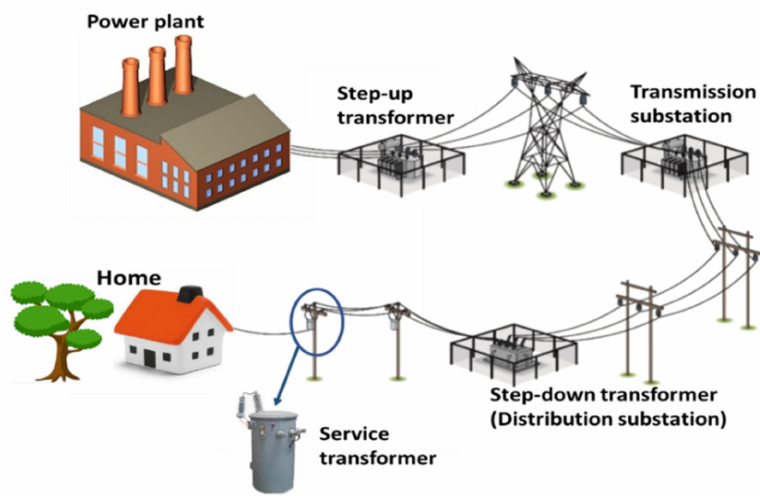
Figure 1. Location of service transformer in the power